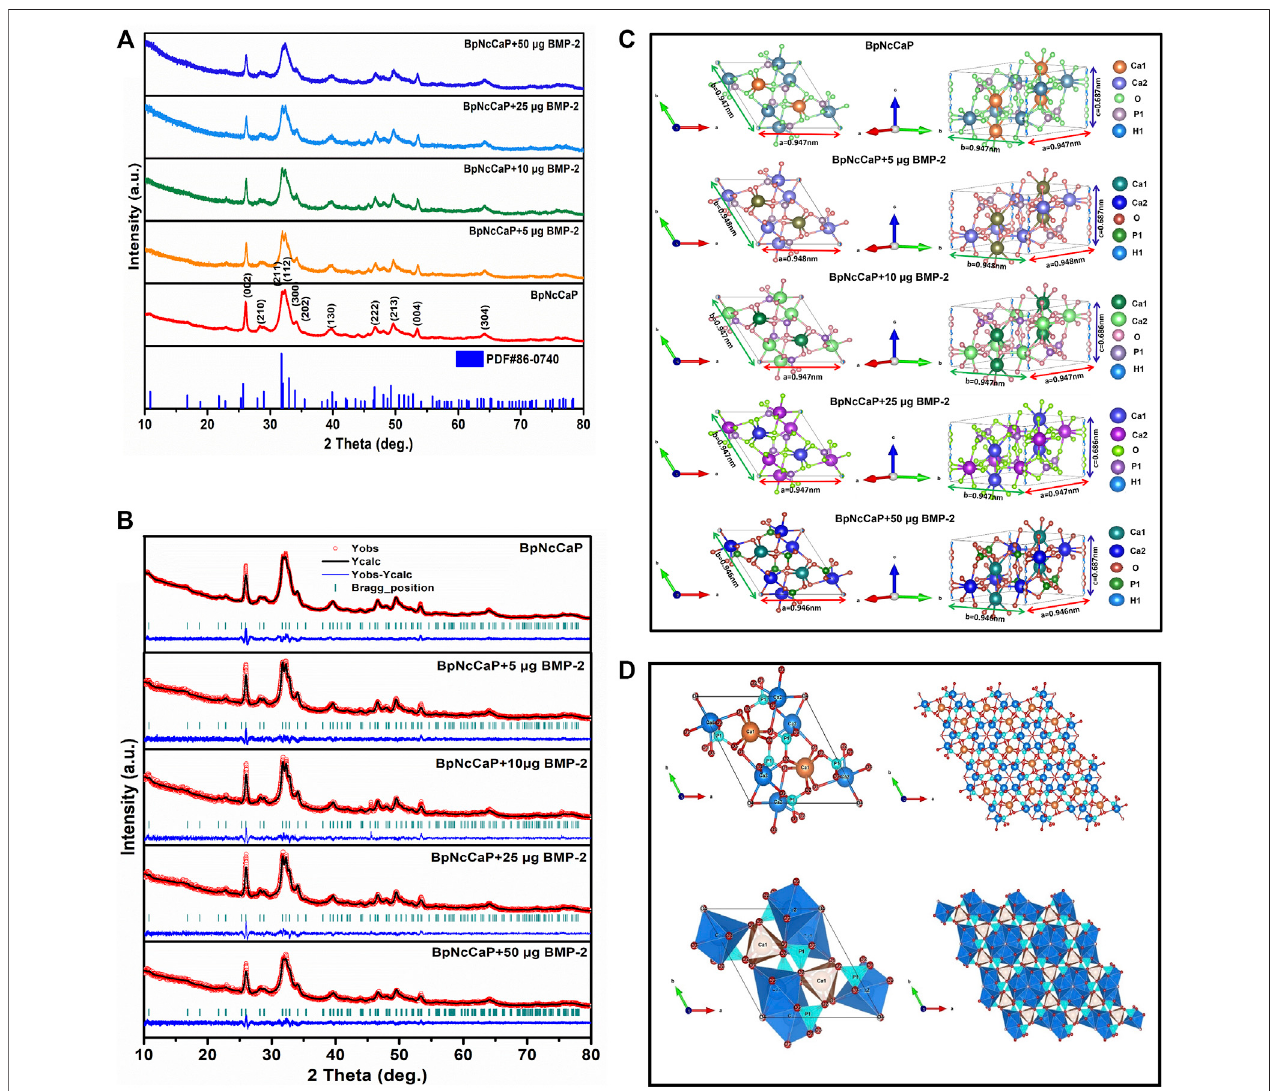
FIGURE 3 | (A) XRDpatternsofBpNcCaPswithoutorwith5/10/25/50 μ gBMP-2aswellasthestandardICSDno.86-0740. (B) Rietveld re fi nementofXRDpatterns for BpNcCaP without or with different amounts (5/10/25/50 μ g) of BMP-2. Black lines: XRD patterns; Red circles: Rietveld re fi ned results; Blue curves: The differences betweentheXRDpatternsandRietveldre fi nementresults;Greenbars:ThecalculatedBraggpeakpositions. (C) RepresentationoftheunitcellsofBpNcCaPswithoutorwith different amounts (5/10/25/50 μ g) of BMP-2. (D) Visualization of structures of ball-and-stick and polyhedral models along with the c-axis for BpNcCaP.